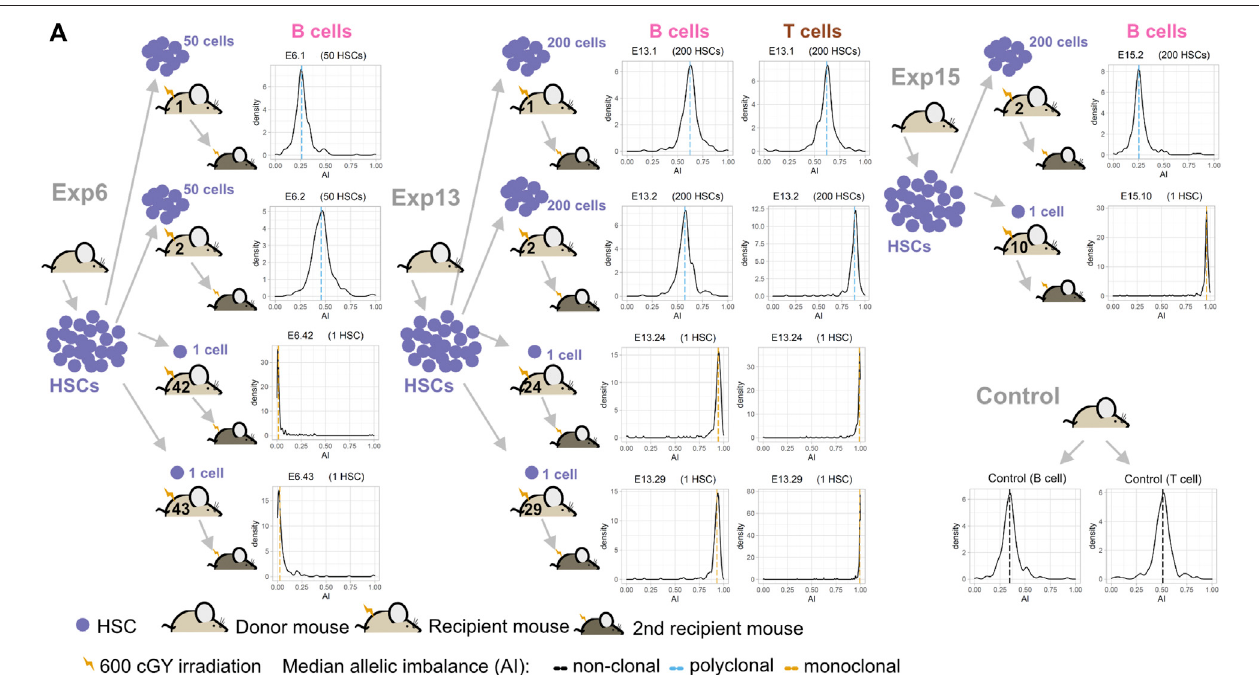
FIGURE 2 | Single-HSC reconstitutions produce clonal hematopoietic systems. (A) Schematic representation of single and multiple HSC reconstitutions that originated the samples used for RNA-seq in this study (experiments E6, E13, and E15). In each experiment, HSCs isolated from one donor mouse F1(CAST Ly5/Ly5 × B6 Ly5.2/Ly5.2 ) were injected into multiple sub-lethally irradiated recipient animals F1(CAST Ly5/Ly5 × B6 Ly5.2/Ly5.1 ). Different donors were used for each experiment. All animals showed long-term reconstitutions, and both monoclonal and polyclonal cells from primary repopulated animals reconstituted a secondary recipient (see representative cytometry pro fi les in Figure 1 ). The density plots represent the allelic ratios of X chromosome-linked genes for each sample, as measured by RNA-seq. (B) AIofX-linkedgenesandX-ChromosomeInactivation(XCI)escapeegenes.ViolinplotssuperimposingdotplotsofX-linkedgenesallelicratiosperclonal/polyclonalB/ T cell sample. For grey dots, the opacity re fl ects the relative abundance in trimmed mean of M (TMM)-normalized counts. Genes signi fi cantly escaping XCI (green dots) aretheonesforwhichtheAIvalueissigni fi cantlyabove(orbelow)themedianAIvalueofallgenesplus(orminus)0.1whentheCAST(orB6)Xchromosomeisexpressed (more details are given in the Materials and Methods section). (C) X chromosome ideogram annotating the location of XCI escapee genes con fi rmed in this study for B and T cells (upper ideogram) and in the literature (lower ideogram). The AI of XCI escapee genes are denoted in pink (for B cell samples) and brown (for T cell samples).